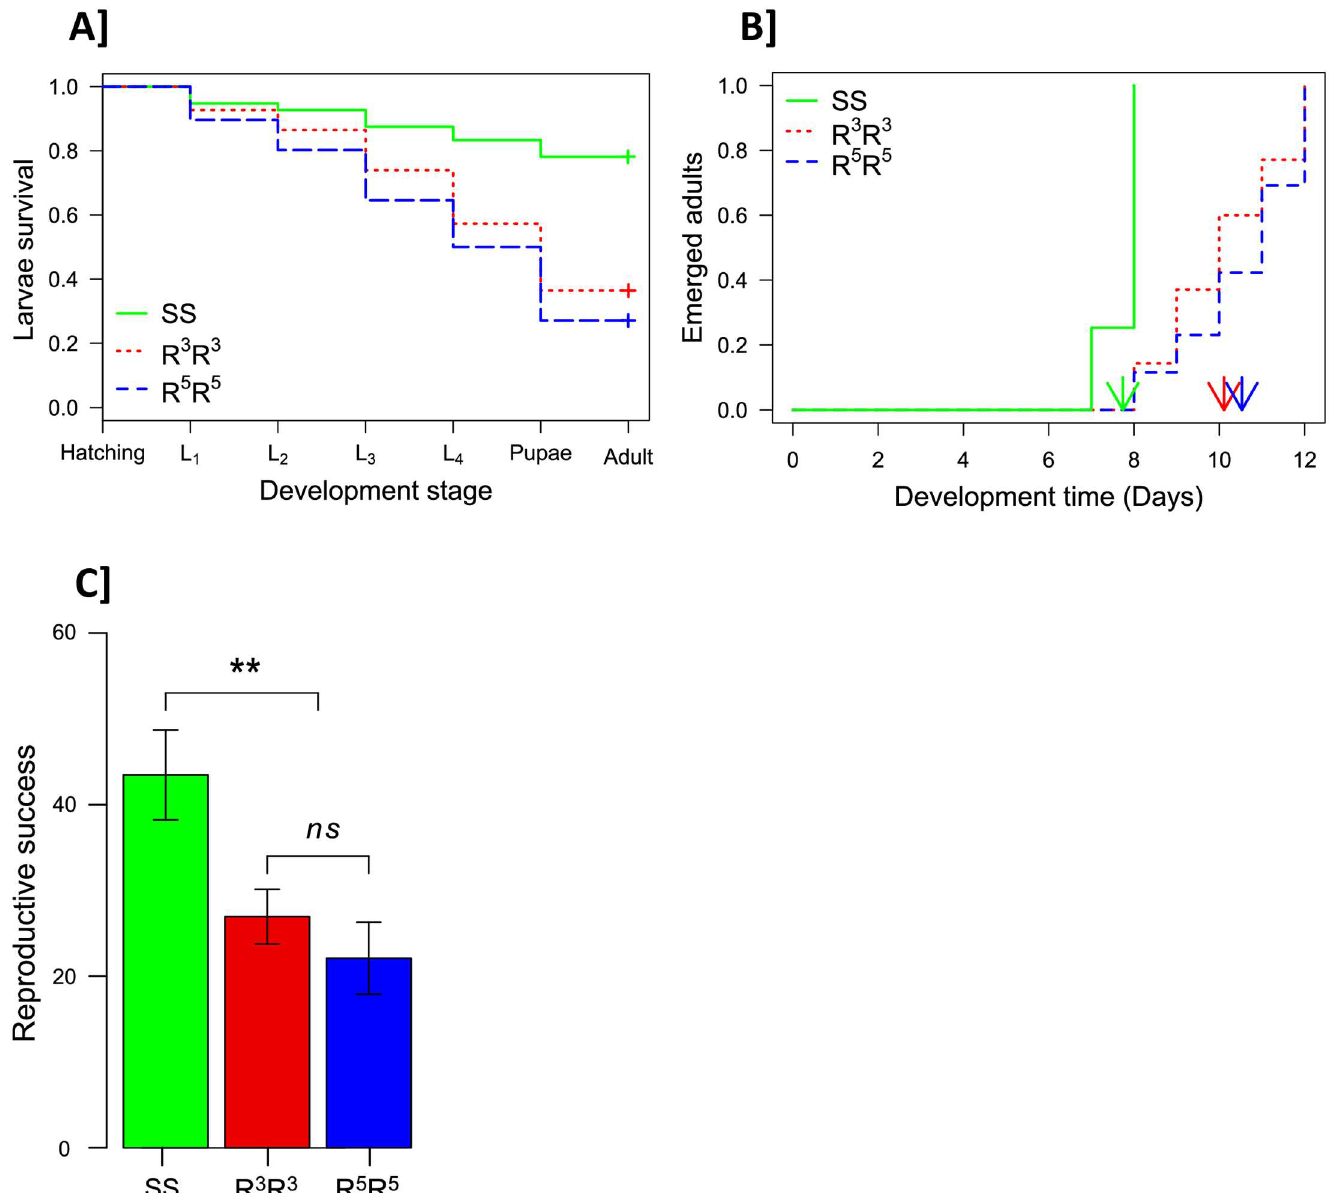
Fig 4. Life history traits for the KisumuP (SS), AcerkisR 3 (R 3 R 3 ) and AgRR5 (R 5 R 5 ) strains. (A) Larval mortality : the proportionof larvae survivingat each development stage is presented,from hatchingto emergence (L i is the larval stage i ); "+" indicates the proportionof emergedadults. (B) Development time : the proportionof emerged adults on each day after the start of the experiment is presented for each genotype; arrows indicate the mean development time of each genotype. (C) Female fecundity : the mean numberof larvae per female in each strain is presented with its standarderror; the significanceof differences in fertility is indicated(n.s., p > 0.05; ** , p < 0.01). Underlying data can be found in DRYAD http://dx.doi.org/10.5061/dryad.